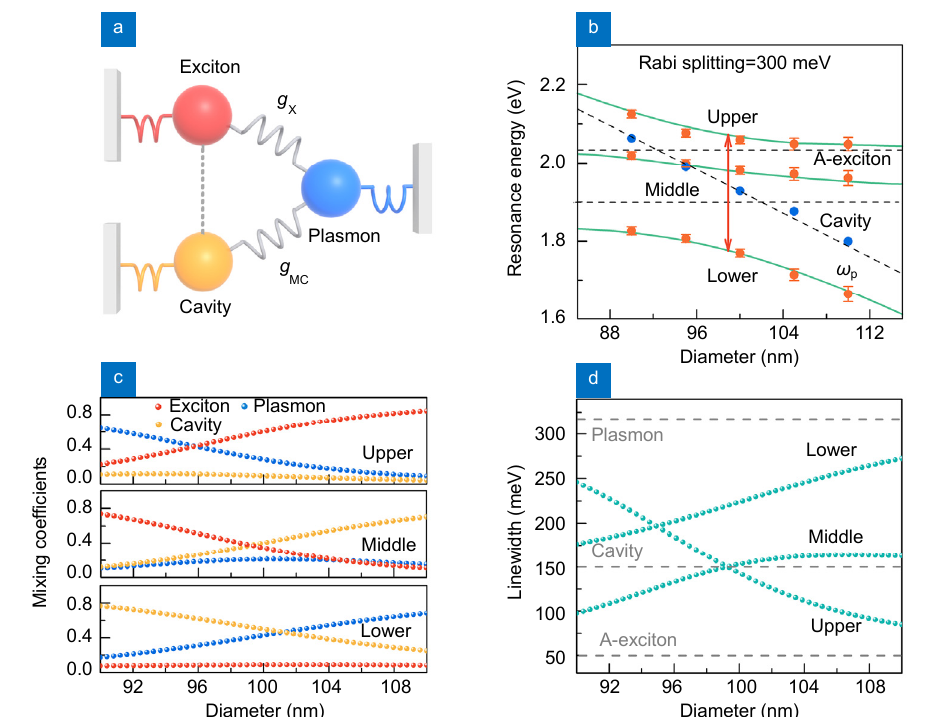
Fig. 4 | Anticrossing behavior of the strong plasmon-exciton-cavity coupling. ( a ) The three-coupled harmonic oscillator model, which in- cludes the surface plasmons, A-exciton, and microcavity mode as three oscillators. ( b ) Energies of reflectivity dips as a function of the nanodisk diameter extracted from the reflectivity spectrum. Red dots with error bars show energies obtained from the reflectivity spectrum. The horizontal black dashed lines respectively represent the A-exciton and the microcavity resonant energy. The black slanted short-dashed line represents plasmon resonance mode. Three green solid curves correspond to theoretical fits of hybrid branches based on the three-coupled oscillator model. The error bar represents the standard error of a set of measurements. ( c ) Hopfield coefficients for plasmon, exciton, and microcavity contributions to upper, middle, and lower hybrid states as a function of diameter, calculated using the three-coupled oscillator model, which provide the weighting of each constituent. ( d ) Reflectivity spectral linewidths of the upper, middle, and lower branch modes as a function of nanodisk